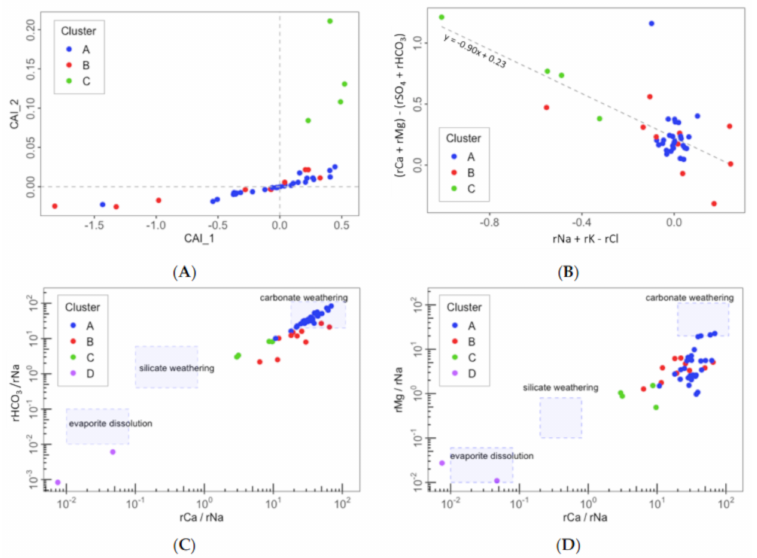
Figure 6. ( A ) Chloro-Alkaline Indexes (CAI_1 and CAI_2) relationship; ( B ) (rCa + rMg) − (rSO 4 + rHCO 3 ) vs. (rNa + rK − rCl); ( C ) bivariate mixing diagrams of Na-normalized HCO 3 vs. Ca; and ( D ) Na-normalized Mg vs. Ca; where ‘r’ means that the concentration is in